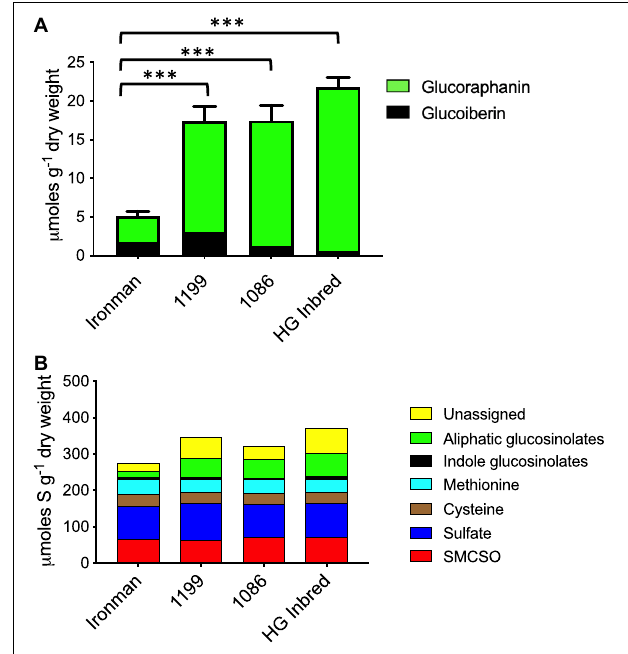
FIGURE 1 | (A) Aliphatic (methionine-derived) glucosinolates in the standard broccoli F 1 hybrid Ironman and in three high glucoraphanin broccoli genotypes, 1199, 1086, and high-glucoraphanin (HG). Ironman has significantly fewer glucosinolates than each of the three high glucoraphanin genotypes ( ∗∗∗ p ≤ 0.0001; Tukey’s multiple comparison test details in Supplementary Table 3 ). (B) Partitioning of sulphur within the major sulphur-containing metabolites in Ironman, 1199, 1086, and HG. There are no significant differences ( p < 0.05) in the total sulphur content or any specific metabolite apart from aliphatic glucosinolates as shown in panel (A) .